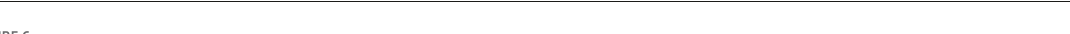
FIGURE6 genes in different I. nil tissues: the root, embryo, seed coat, flower, leaf, and stem. (E) Expression profiles of sweet potato duplicated NBS-encoding genes in response to various stress: drought, salt, methyl jasmonate (MeJa), abscisic acid (ABA), and salicylic acid (SA). (F) Expression profiles of I. trifida duplicated NBS-encoding genes in response to various stress: beta-aminobutyric acid biotic stress experiment (TTF_BABA), cold stress at 10/4 ◦ C day/night experiment (TTF_COLD), biotic stress control (TTF_BICO), benzothiadiazole S-methylester biotic stress experiment (TTF_BTHT), 6-benzylaminopurine 10 uM hormone stress experiment (TTF_BAPT), hormone control experiment (TTF_HOCO), Indole-3-acetic acid 10 uM hormone stress experiment (TTF_IAAT), gibberellic acid 50 uM hormone stress experiment (TTF_GA3T), heat stress at 35/35 ◦ C day/night experiment (TTF_HEAT), drought and salt control experiment (TTF_DSCO), heat control at 28/22 ◦ C day/night experiment (TTF_HECO), cold control at 28/22 ◦ C day/night experiment (TTF_COCO), NaCl salt stress experiment (TTF_NACL), mannitol drought stress experiment (TTF_MANN) and abscisic acid 50 uM hormone stress experiment (TTF_ABAT). (G) Expression profiles of I. triloba duplicated NBS- encoding genes in response to various stress: beta-aminobutyric acid biotic stress experiment (TTB_BABA), cold stress at 10/4 ◦ C day/night experiment (TTB_COLD), biotic stress control (TTB_BICO), benzothiadiazole S-methylester biotic stress experiment (TTB_BTHT), 6-benzylaminopurine 10 uM hormone stress experiment (TTB_BAPT), hormone control experiment (TTB_HOCO), Indole-3-acetic acid 10 uM hormone stress experiment (TTB_IAAT), gibberellic acid 50 uM hormone stress experiment (TTB_GA3T), heat stress at 35/35 ◦ C day/night experiment (TTB_HEAT), drought and salt control experiment (TTB_DSCO), heat control at 28/22 ◦ C day/night experiment